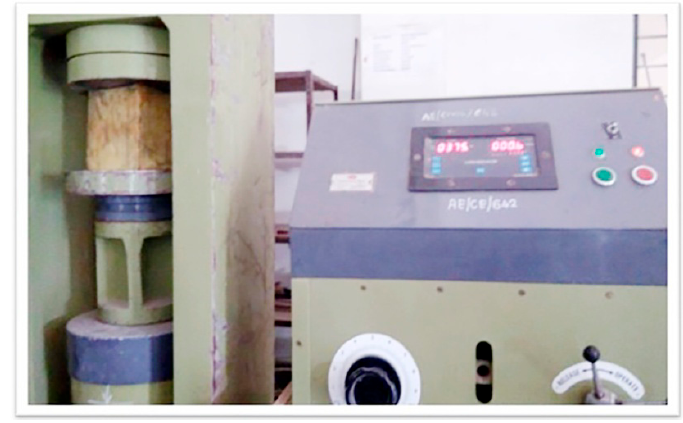
Figure 2. Compressive strength test. Table 7. Acid resistance test